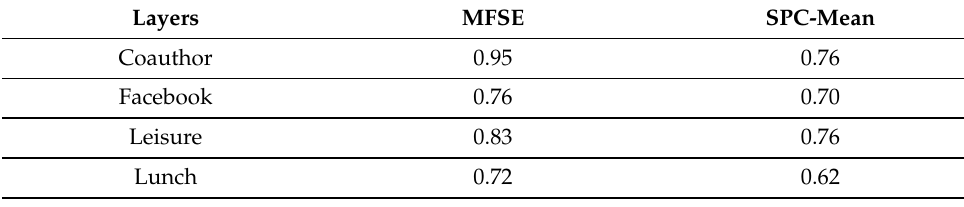
Table 4. Densities obtained by MFSE and SPC-Mean on each layer of AU-CS network. Layers MFSE SPC-Mean